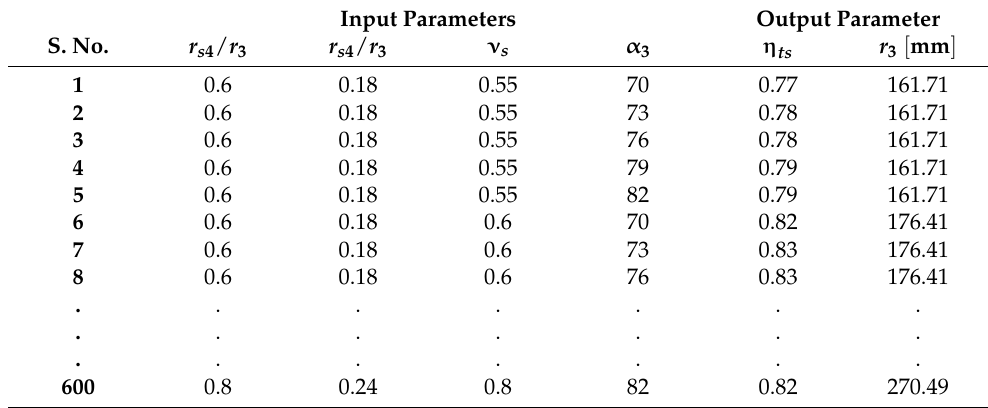
Table 3. Details of the input and output